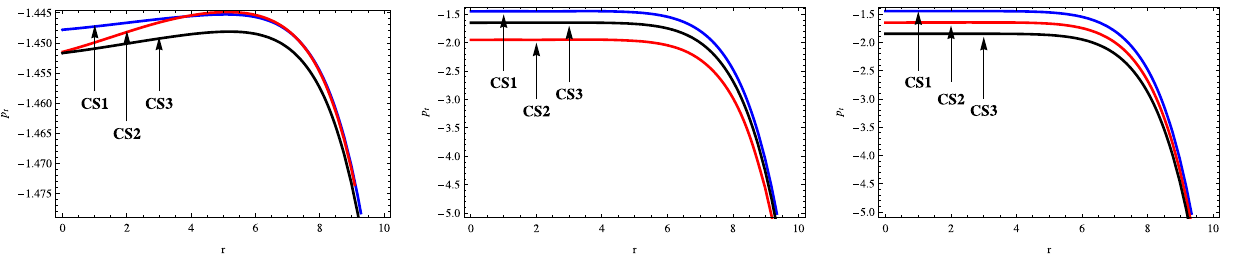
Fig. 5 Variations of transversal pressure p t ( MeV / f m 3 ) versus r ( km ) with the numerical values of A , B and C from Tables 2, 3 and 4